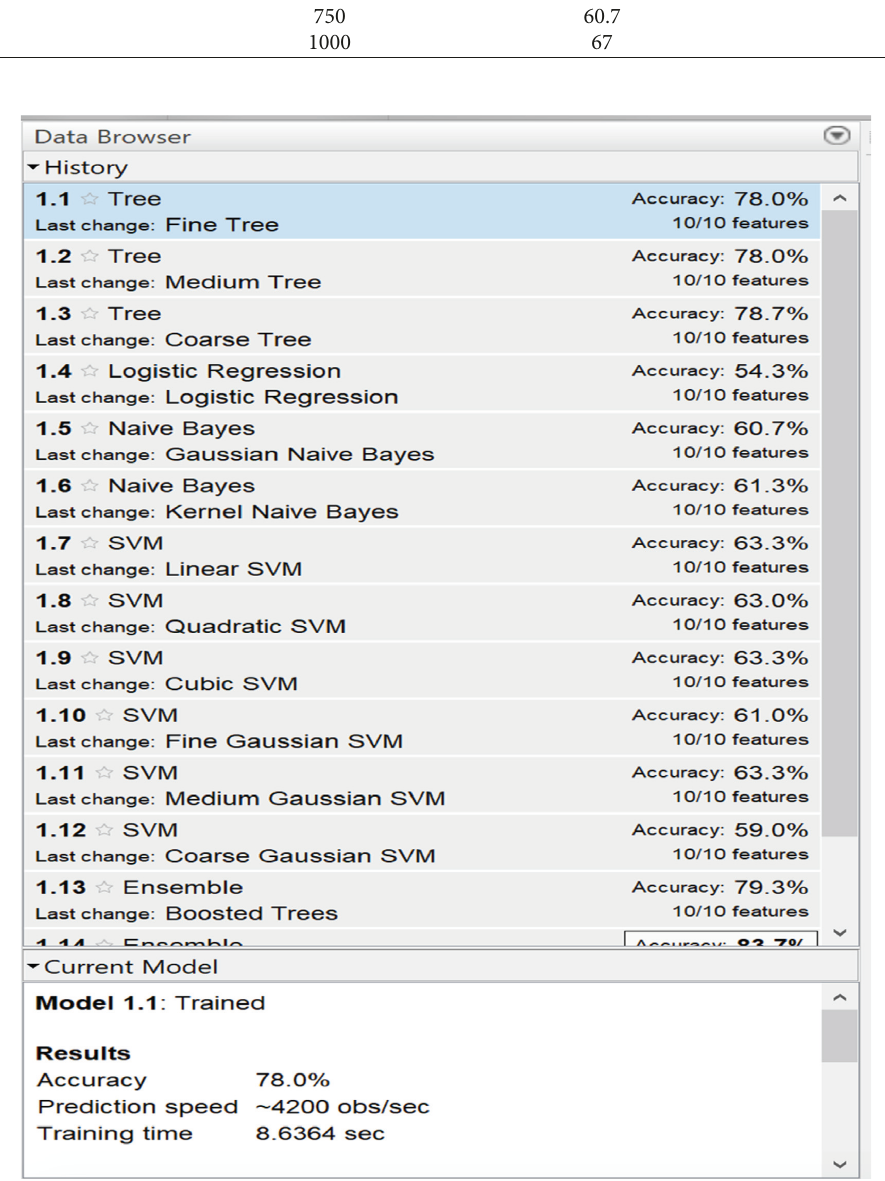
Figure 17: Classification Learner App showing the various algorithms and percentage accuracies in MATLAB.